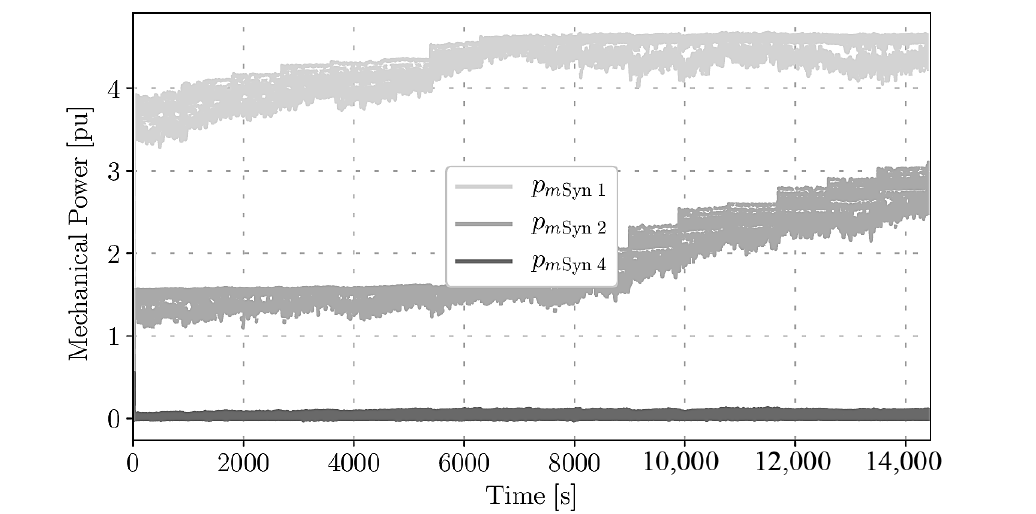
Figure 9. Mechanical power of synchronous generators 1, 2 and 4, for 15-min time period and complete SUC model.